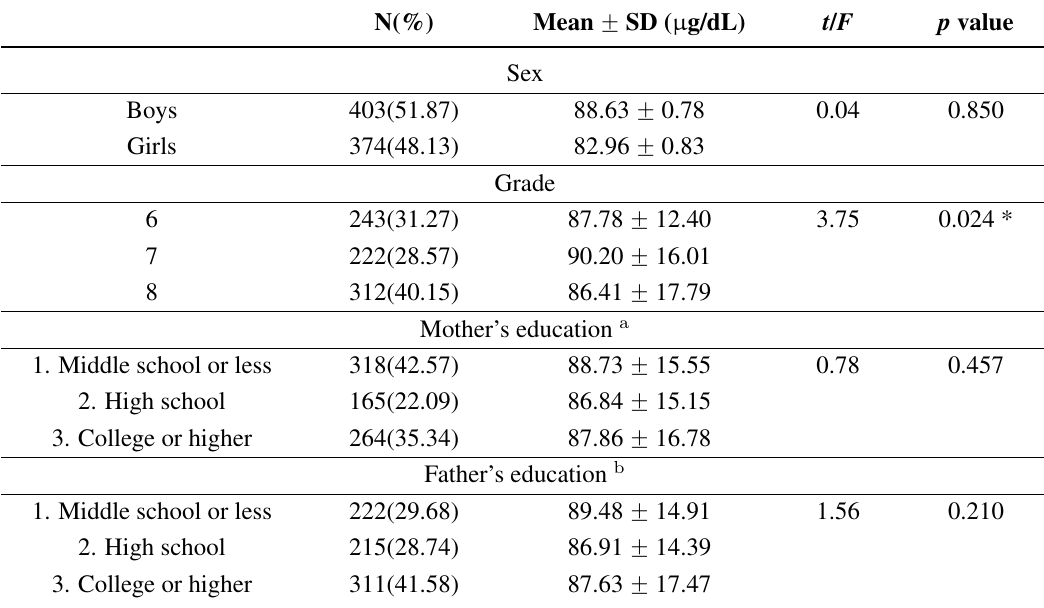
Table 1. Socio-demographic characteristics at adolescence.